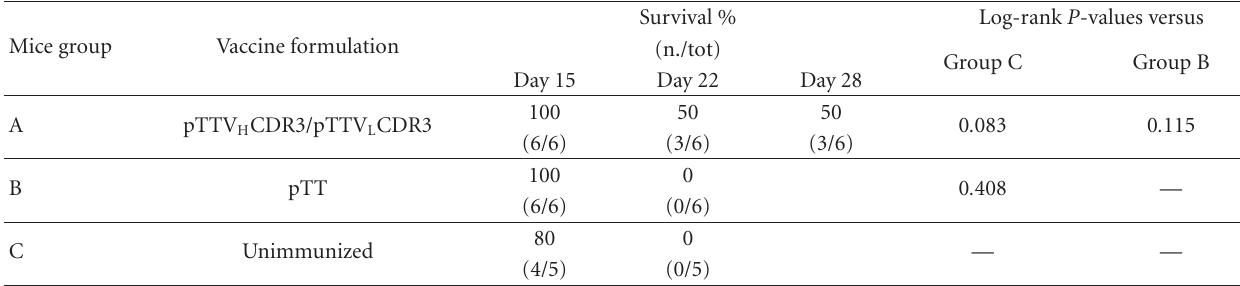
Table 2: Therapeutic vaccination induces life span